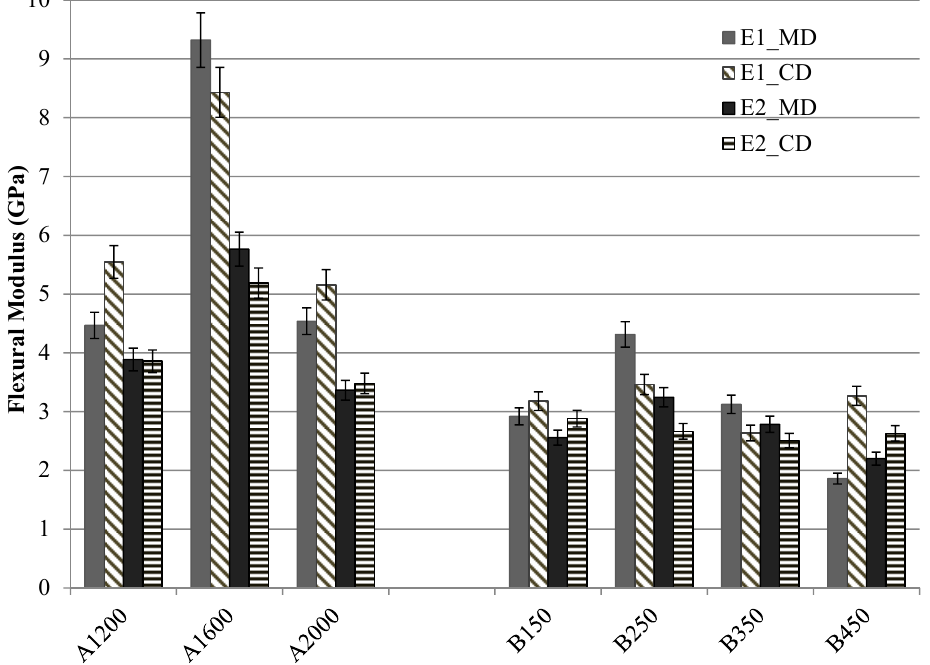
Figure 6. The flexural modulus of set A and set B nonwoven reinforced composites.